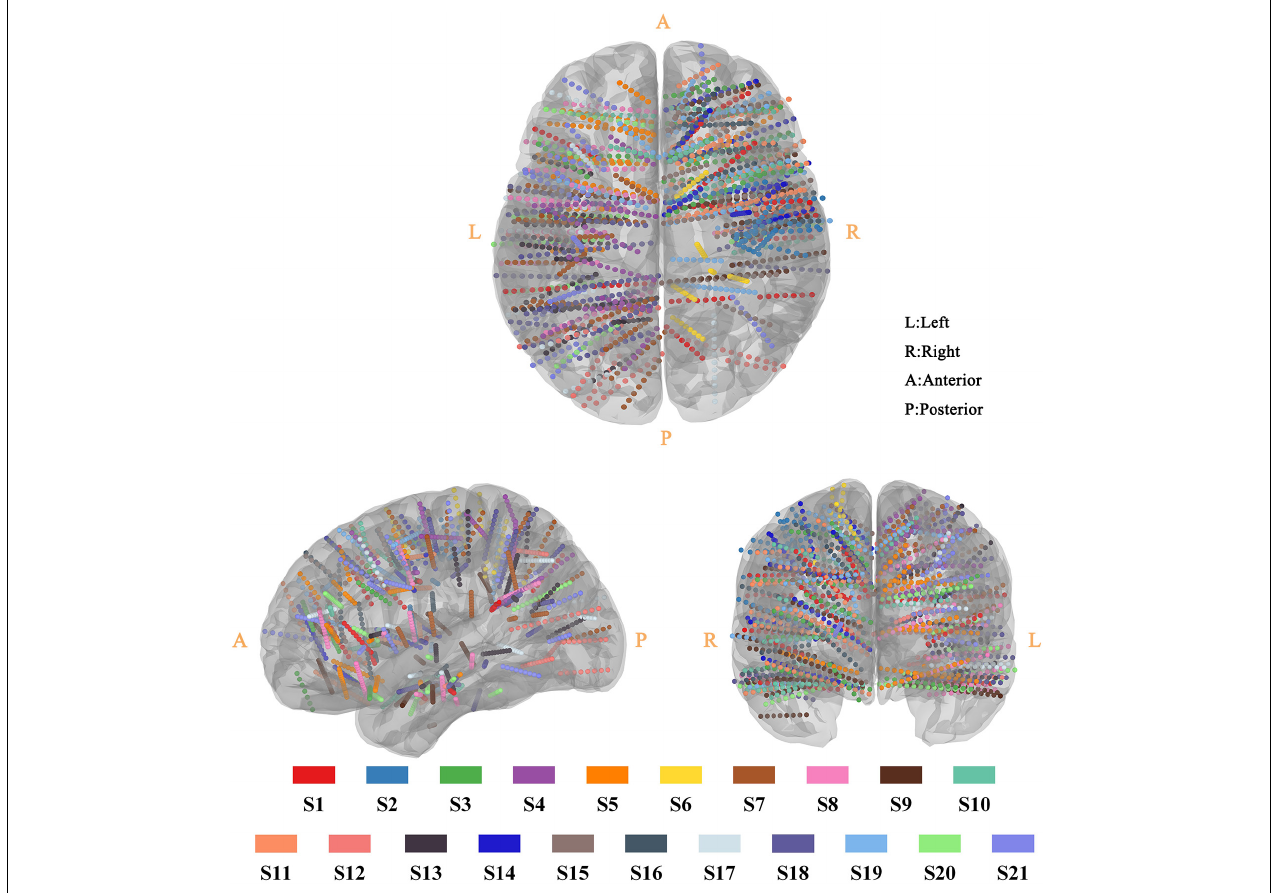
Figure 4G (the Pearson correlation coefficient r = 0.99, p < 0.001; the slope of the linear fit s =